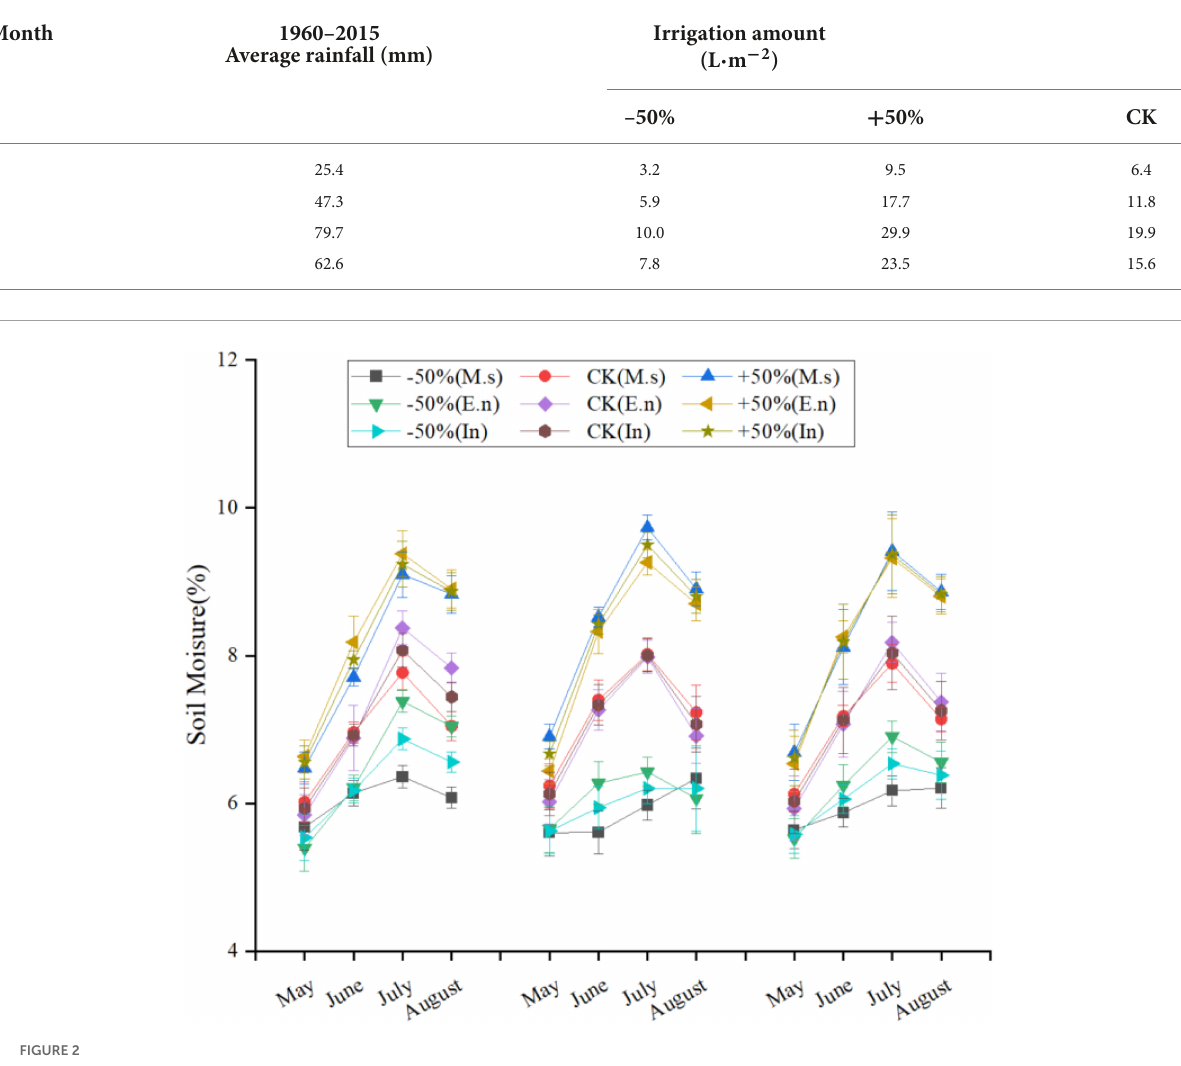
TABLE 1 Irrigation amounts for each treatment group corresponding to the average rainfall for each month of the growing season from 1960 to 2015.